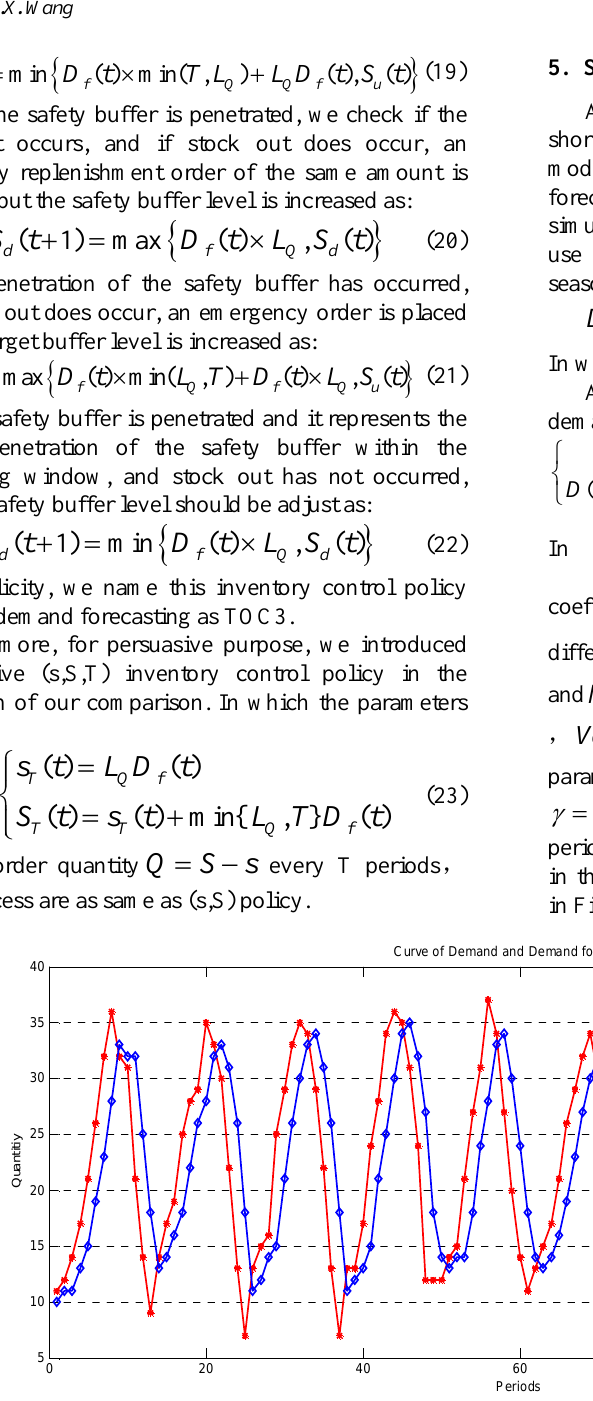
Fig.5. Curve of demand and demand